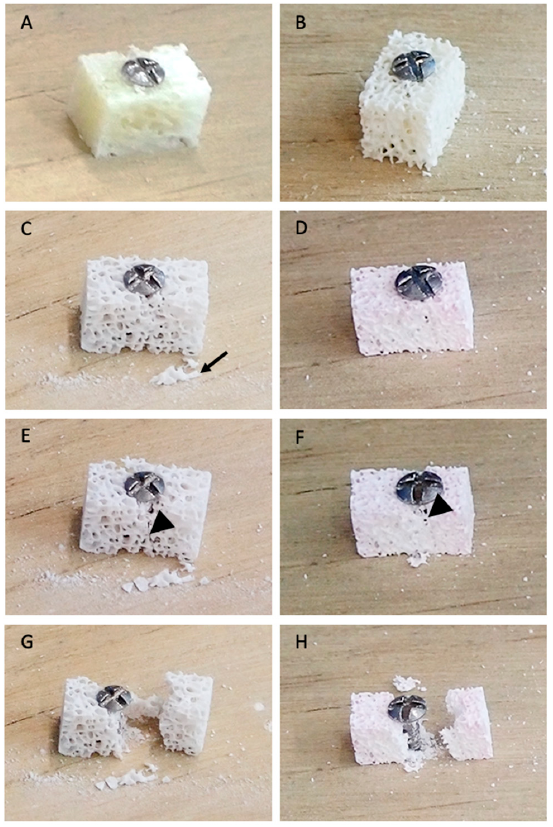
Figure 5. Testing the ability of the bone block to withstand fracture during placement of a bone screw. ( A ) Raw bone, ( B ) boil (6 h), ( C , E , G ) initial boiling (6 h) followed by 550 ◦ C sintering (6 h), ( D , F , H ) initial boiling (6 h) followed by 1100 ◦ C sintering (6 h). ( C ) showed more brittleness in the form of bone fragment chipping; ( E , F ) showed crack formation during screw placement; and ( G , H ) showed bone fracture during excess screw tightening. Arrow = chipped bone fragment; arrowhead = cracks (representative image of n =